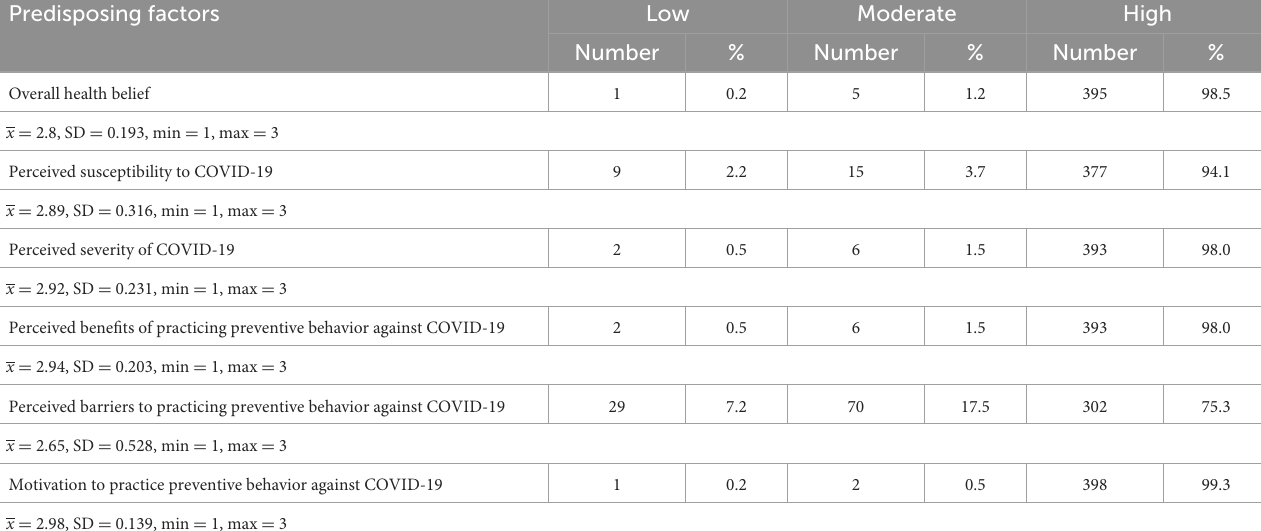
TABLE 2 Descriptive statistics of predisposing factors among taxi drivers ( N = 401). Predisposing factors